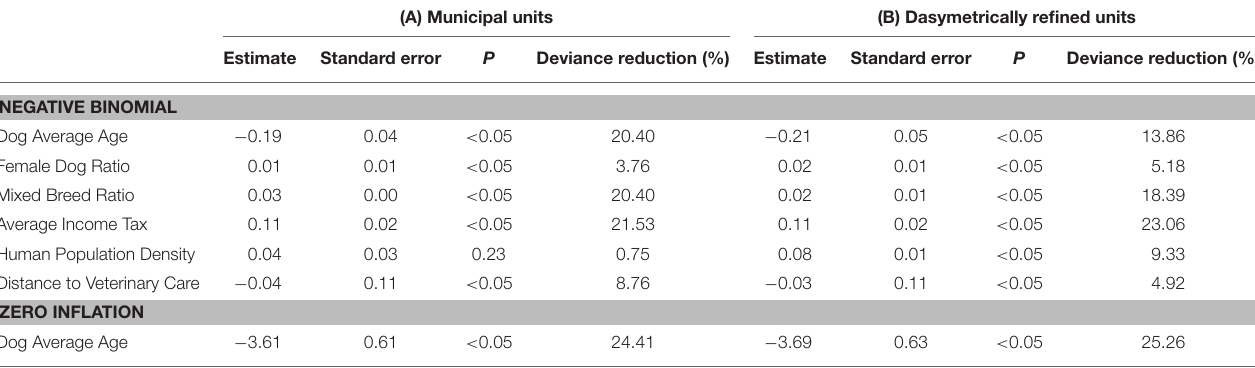
TABLE 3 | Coefficients for the negative binomial model with zero-inflation extension based on the two enumeration types — (A) municipal units and (B) dasymetrically refined